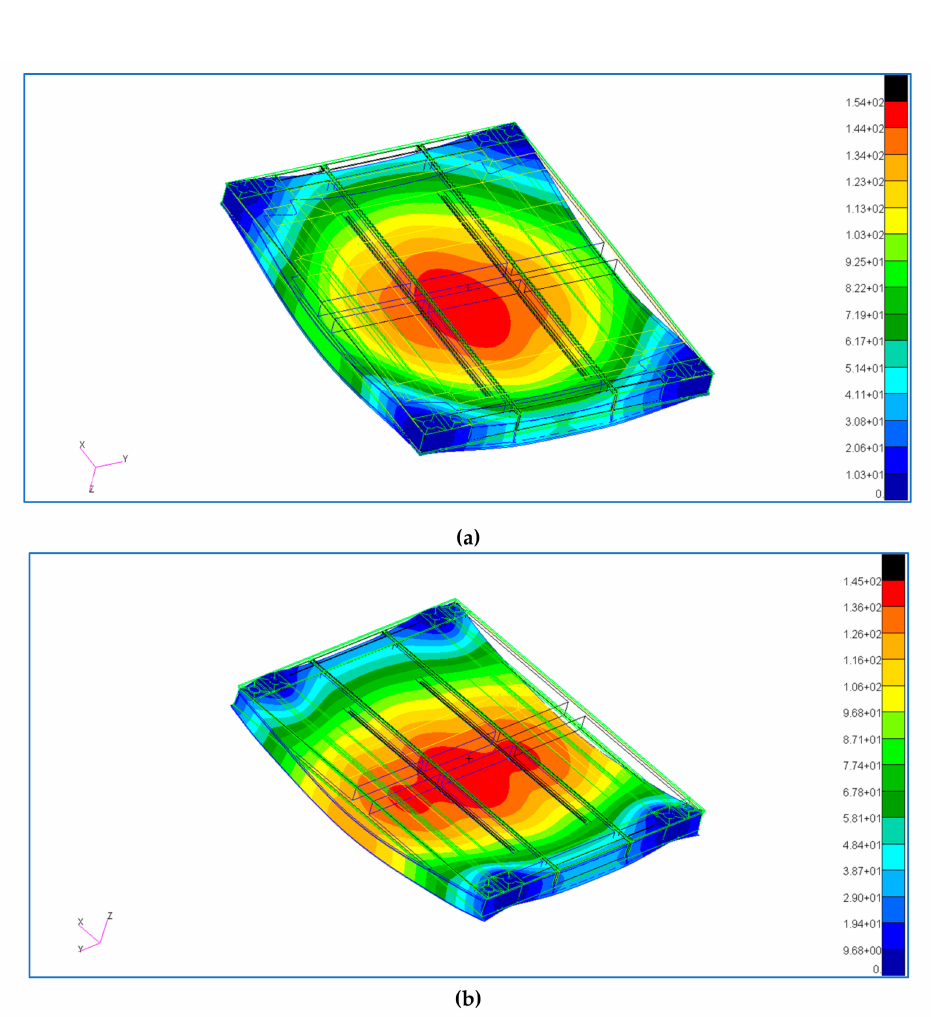
Figure7. Fundamentalmodes: ( a )Externalholesblocked; and( b )Internalholesblocked. Displacements are given in